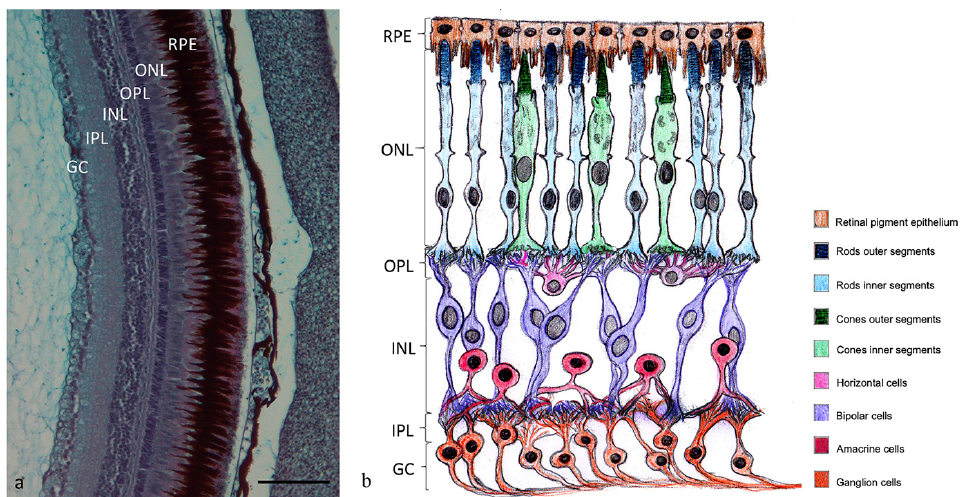
Figure 1. ( a ) Retina of adult zebrafish: RPE, retinal pigment epithelium; ONL, outer nuclear layer; OPL, outer plexiform layer; INL, inner nuclear layer; IPL, inner plexiform layer; GC, ganglion cell layer; Alcian Blue-PAS staining. Magnification 20 × . ( b ) Graphical representation of the cell layers into the